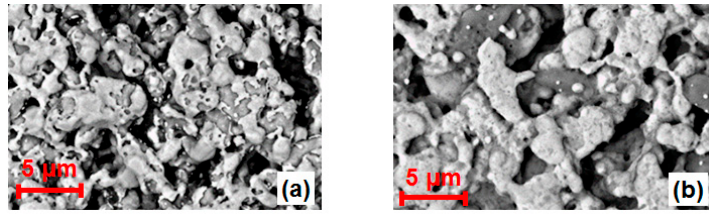
Figure 2. ( a ) ESEM image (top view) of the type I APE; ( b ) ESEM image (top view) of the type II APE.